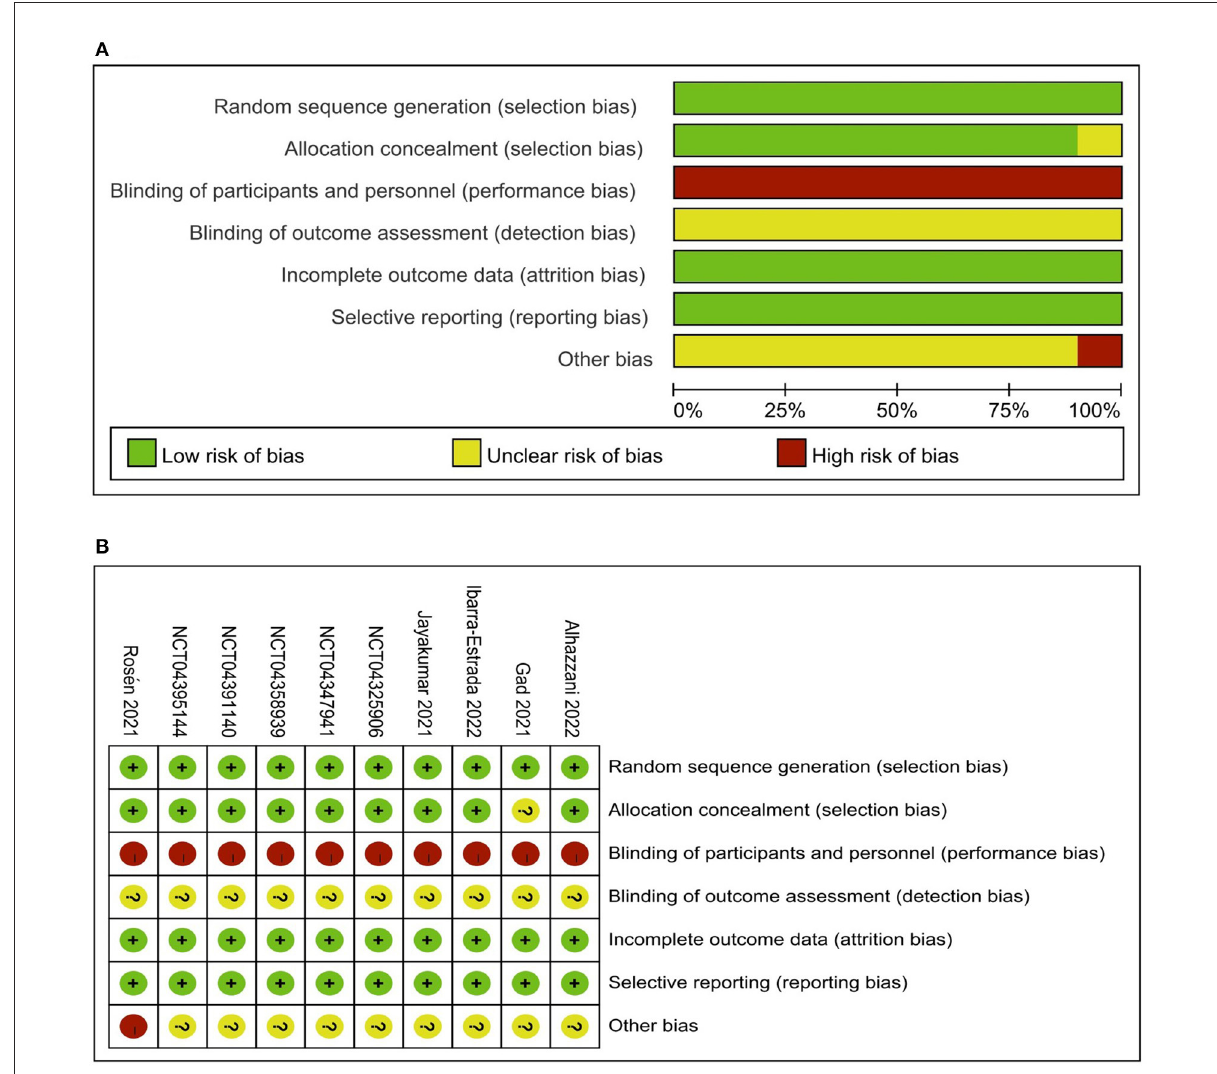
FIGURE2 Risk of bias graph: review authors’ judgements about each risk of bias item presented as percentages across all included studies (A) and Risk of bias summary: review authors’ judgements about each risk of bias item for each included study (B)